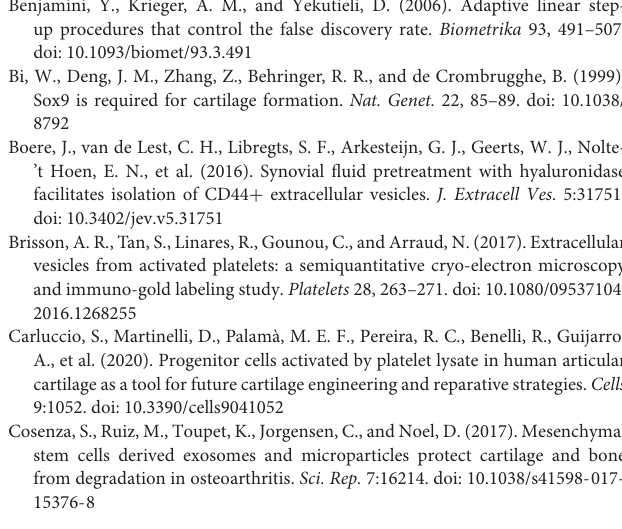
Supplementary Figure 2 | Densitometric analysis of indicated EV marker proteins and lipoproteins from Fig 4A. Data are given as proportional band intensity relative to the respective blood product after pre-clearing (CPRP S2 fraction or hypACT S2 fraction). Supplementary Figure 3 | Densitometric analysis of NF κ B, COX2 and SOX9 expression relative to GAPDH in IL1 β stimulated and unstimulated cells from Figure 6B . Data are given as ratio of the band intensity of the indicated marker relative to GAPDH band intensity. SOX9 intensity was normalised to the lower GAPDH